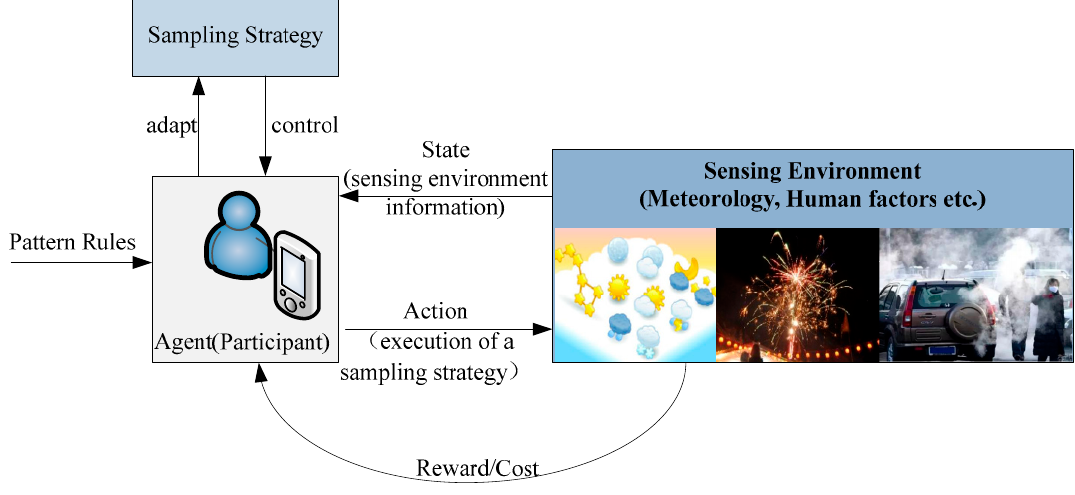
Figure 2. Adaptive Sampling Scheme for Urban Air Quality (AS-air) based on Q -learning.